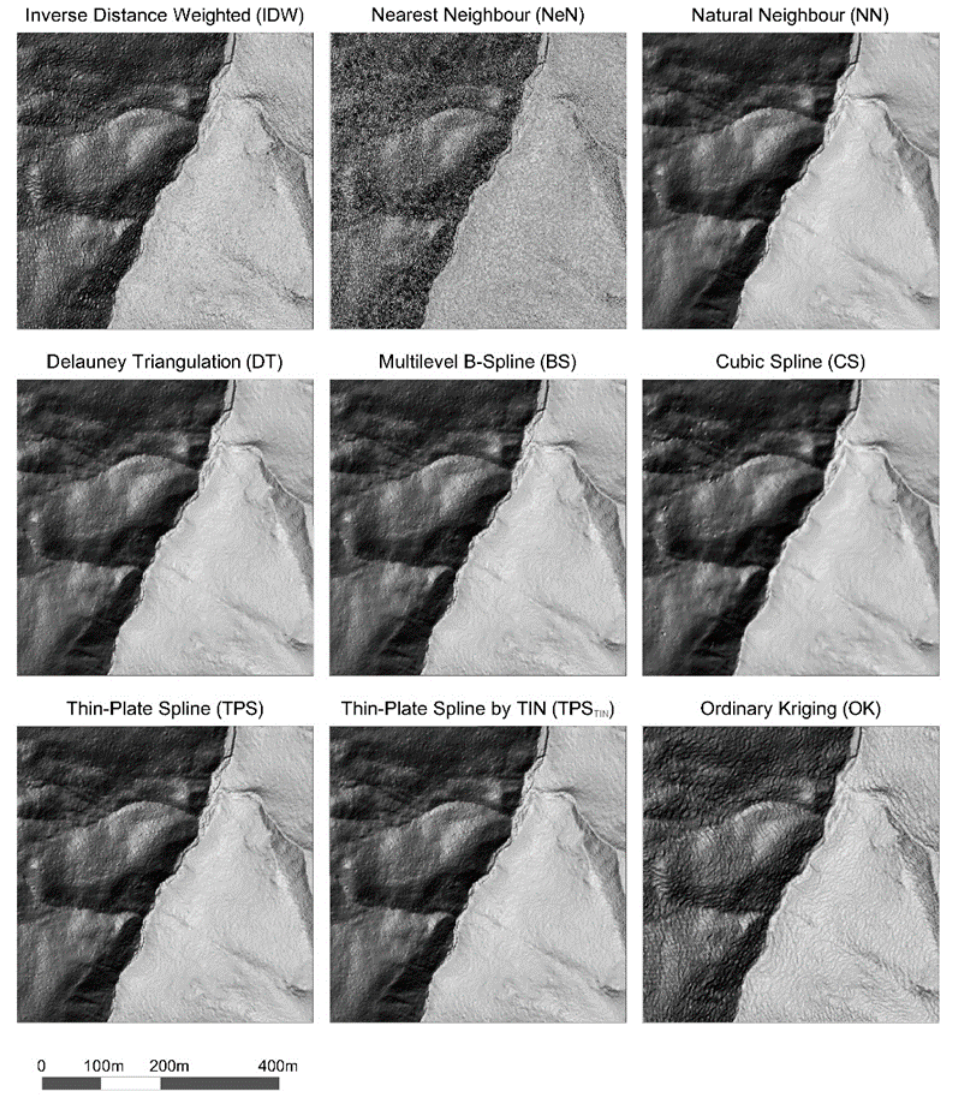
Figure 2. Hillshade models derived from interpolated Digital Terrain Models (DTMs), for a subset of the test site (500 × 500m).